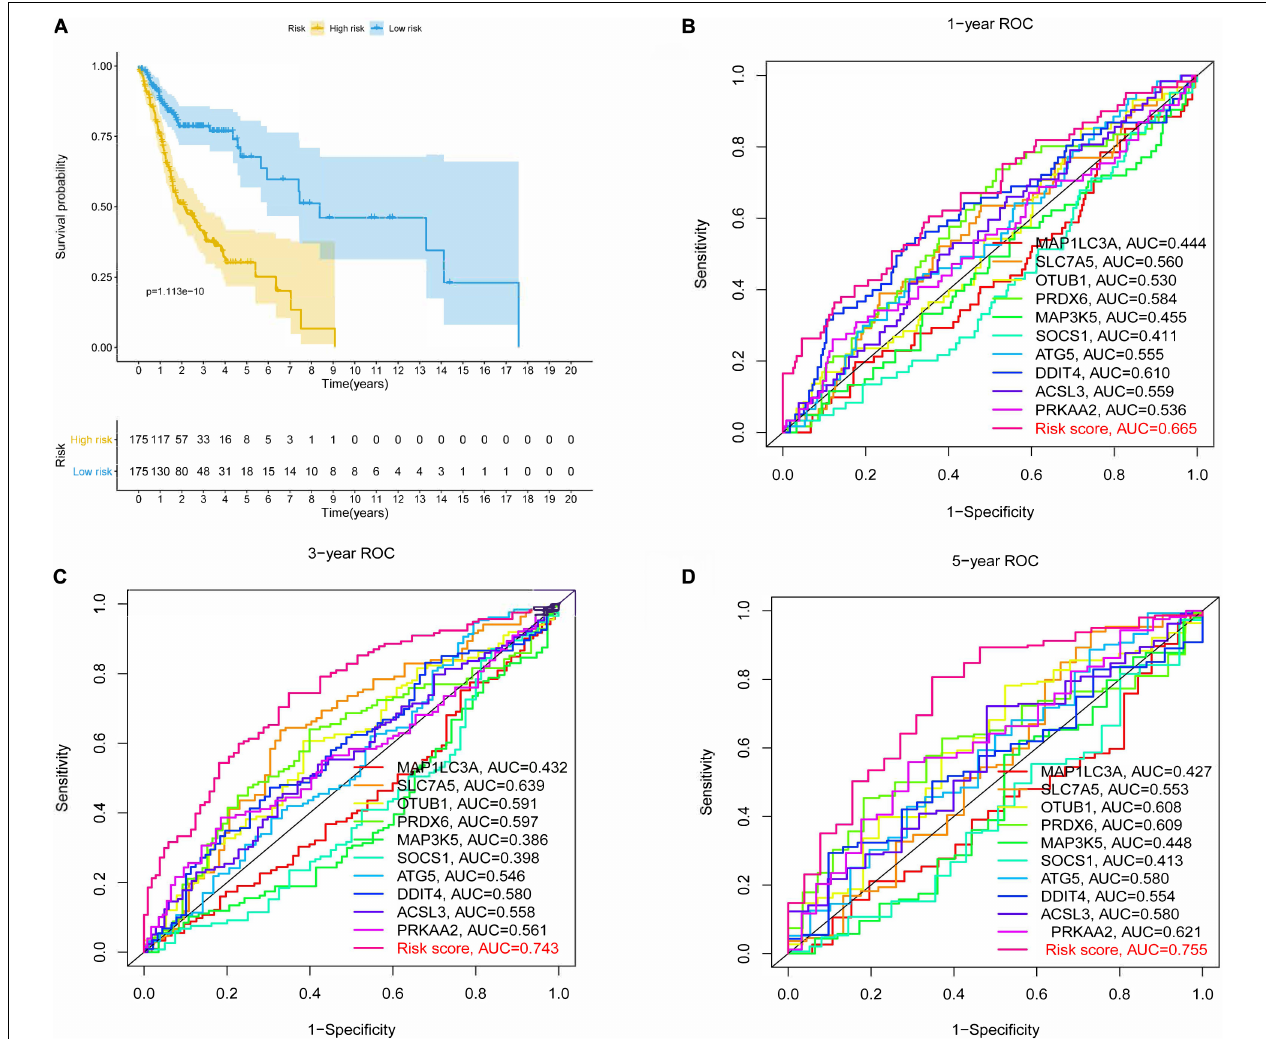
FIGURE 3 | Kaplan-Meier (K-M) survival analysis and receiver operating characteristic (ROC) curves of risk prognostic model in HNSCC patients. (A) K-M survival analysis of risk prognostic model of HNSCC patients in training cohort. (B–D) ROC curves analysis of risk prognostic model of HNSCC patients at 1, 3, and 5 years in training